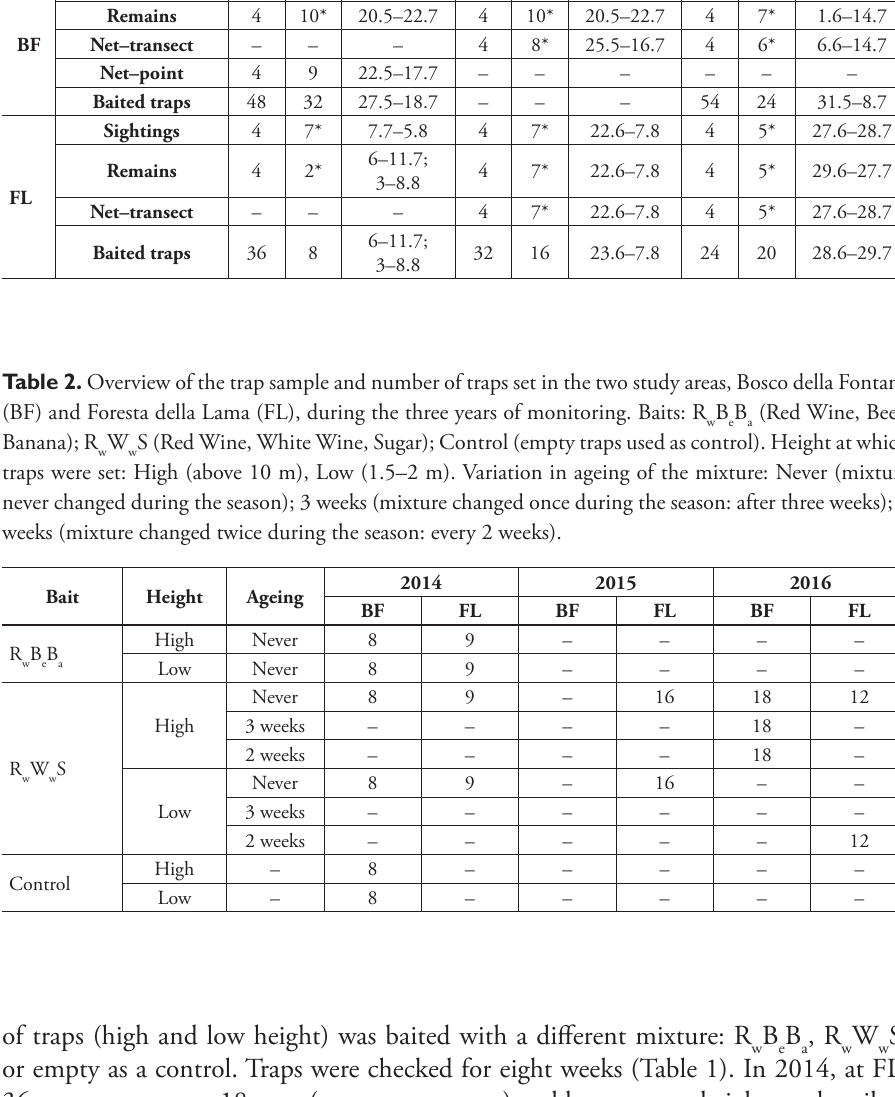
Table 1. Sampling plan at Bosco della Fontana (BF) and Foresta della Lama (FL) during the three years of monitoring. N = number of transects or traps; S = number of surveys; * indicates the number of surveys per transect.